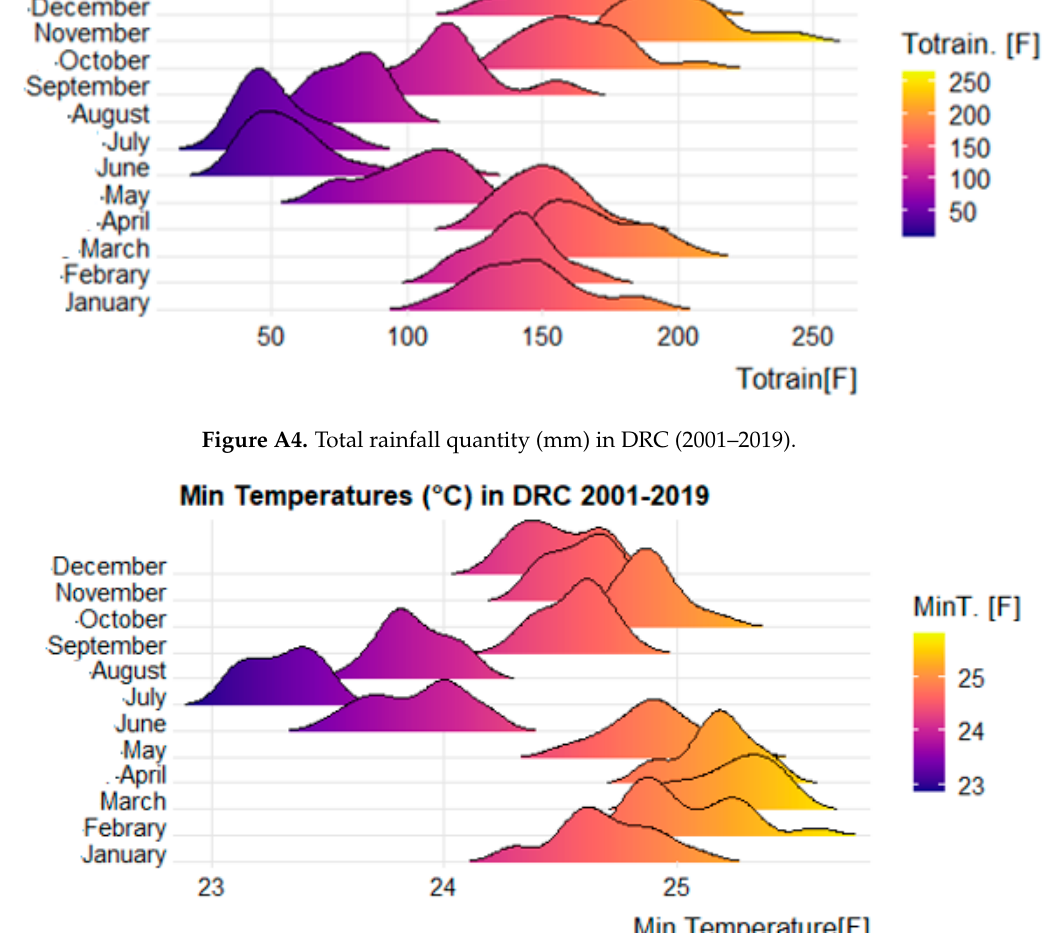
Figure A6. Rainy day (days) in DRC (2001–2019). References 1.